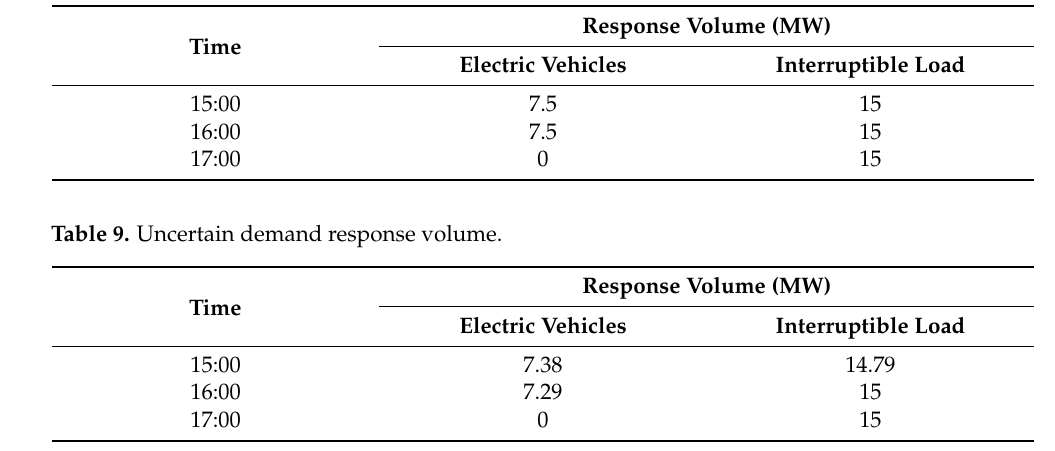
Table 8. Deterministic demand response volume.